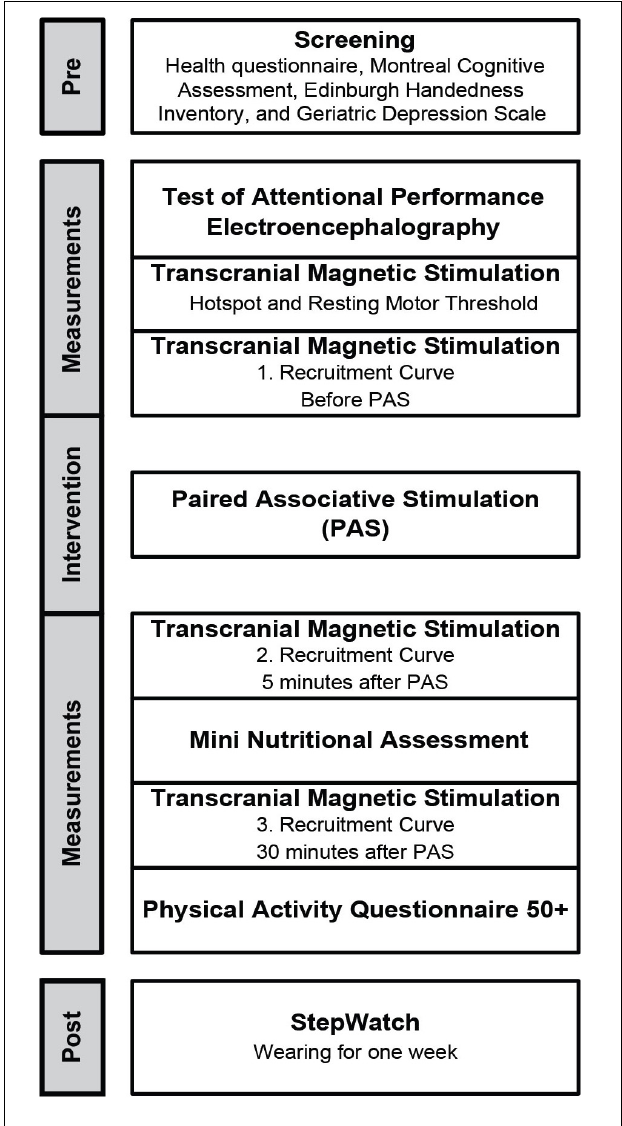
FIGURE 1 | Study flow